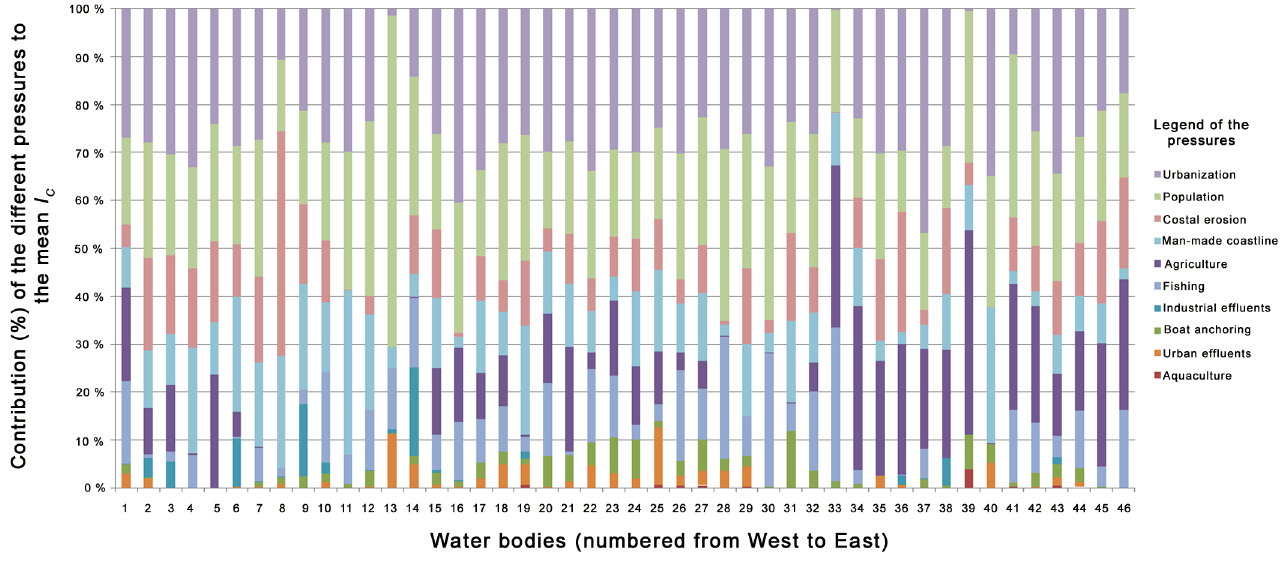
Fig 6. Contribution (in %) of the different pressures to the mean cumulative impact score ( I C ) of each water body. Water bodies are classified from West to East. No unit for I C